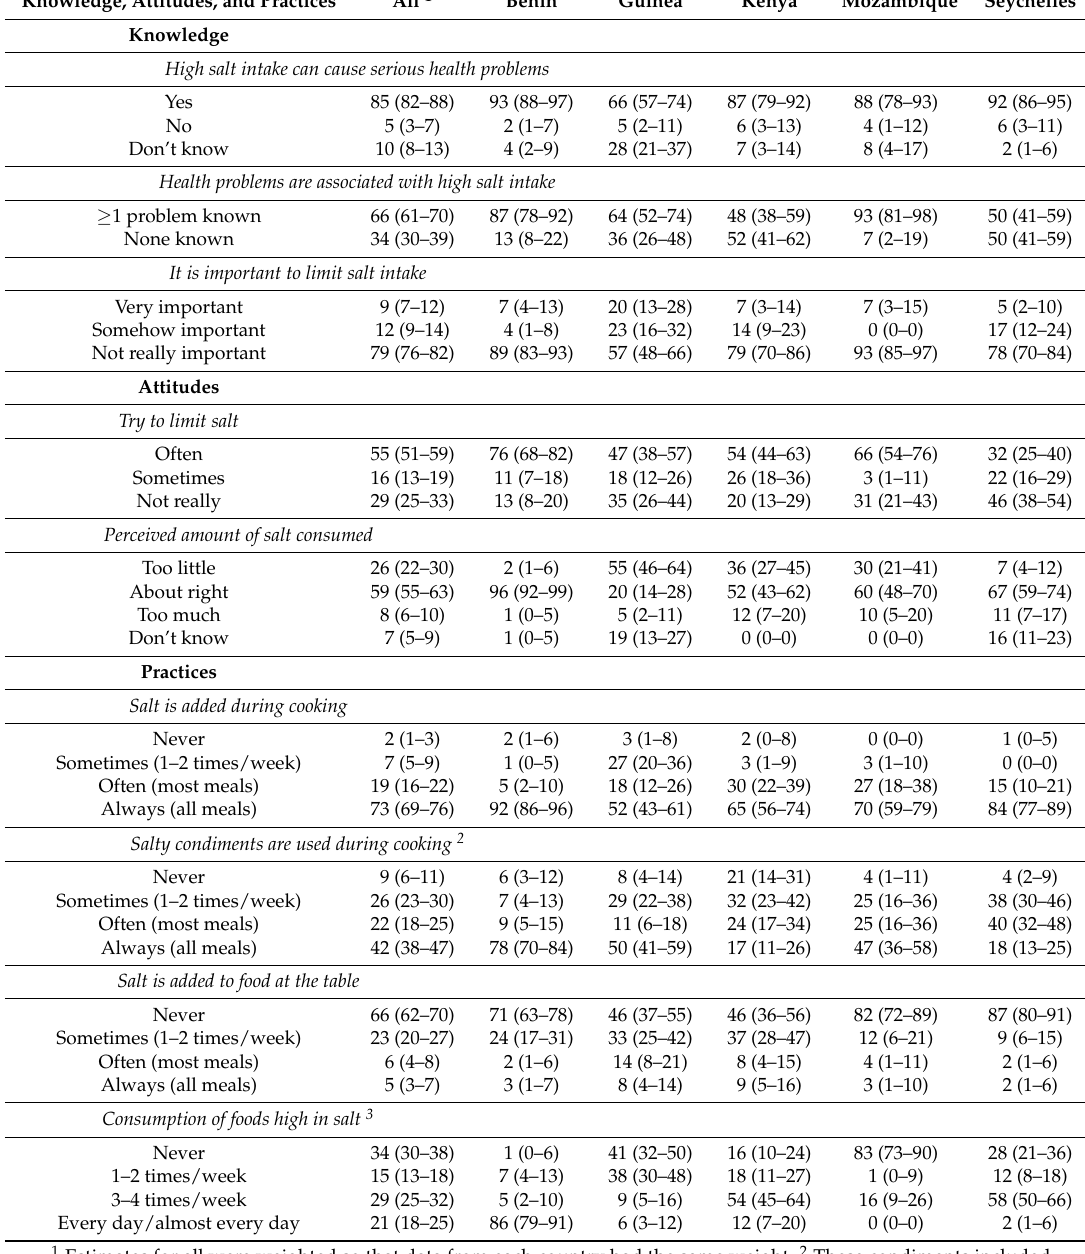
Table 3. Knowledge, attitudes, and practices related to salt intake according to country (in